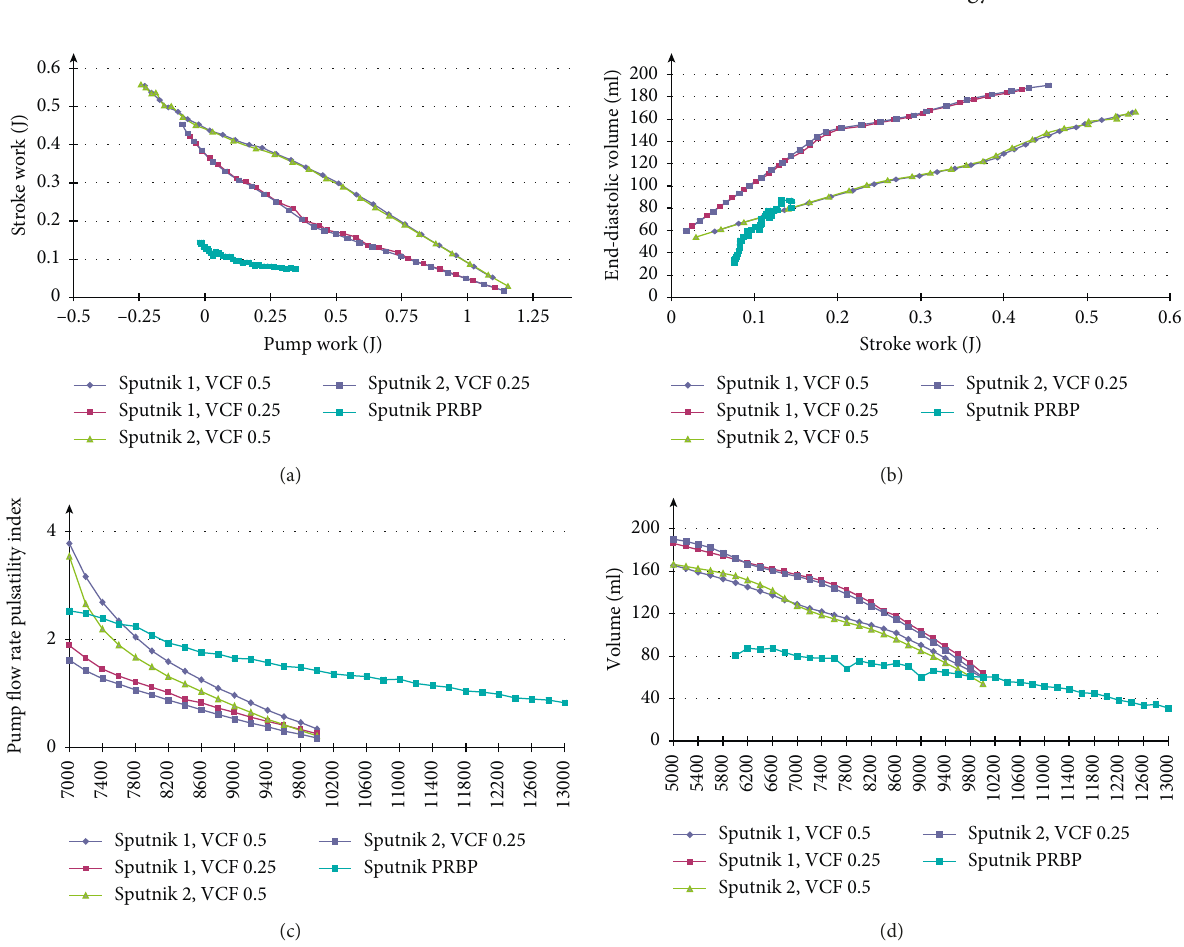
Figure 8: (a) Relationship between average stroke work and average hydraulic pump work for Sputnik 1 and Sputnik 2 LVADs supporting left ventricle with ventricle contractility factors (VCFs) of 0.5 and 0.25 and for Sputnik PRBP supporting pediatric left ventricle. (b) Relationships between end-diastolic volume and average stroke work for adult and pediatric LV supported by Sputnik 1, Sputnik 2 LVADs, and Sputnik PRBP, respectively. (c) Pump flow rate pulsatility indices for Sputnik 1 and Sputnik 2 LVADs supporting left ventricle with ventricle contractility factors (VCFs) of 0.5 and 0.25 and Sputnik PRBP supporting pediatric left ventricle in the speed ranges of 7000–10000rpm and 7000–13000rpm, respectively, with 200 rpm step. (d) End-diastolic volumes of left ventricle during support by